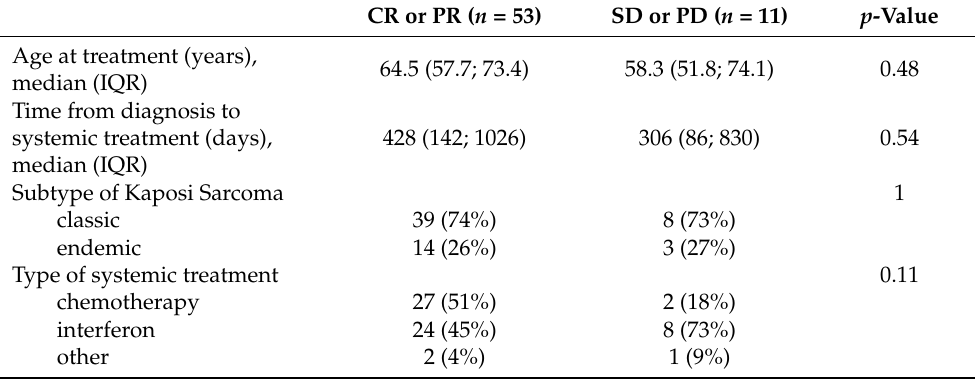
Table A1. Factors associated to first systemic treatment line best overall response. CR: Complete Response. PR: Partial Response. SD: Stable Disease. PD: Progressive